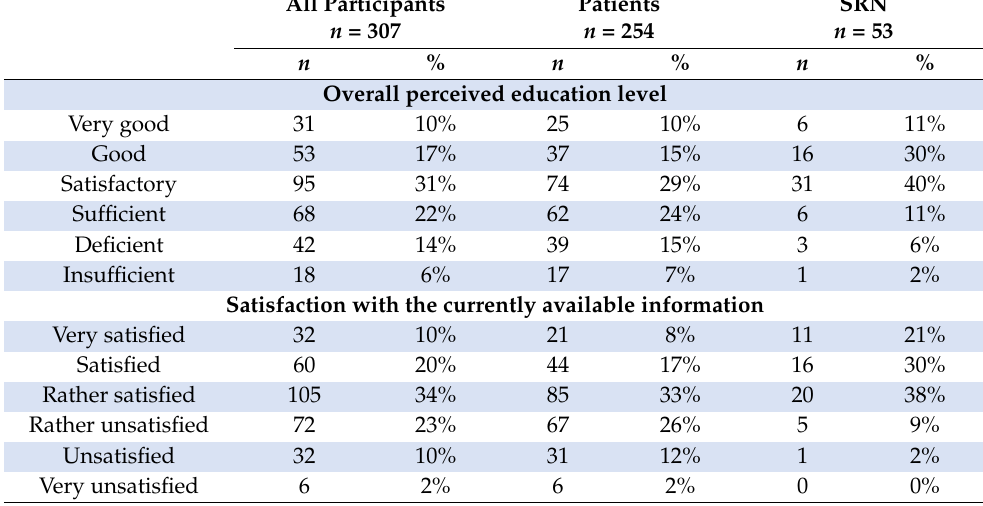
Table 3. Results—patients’ compared to SRN-perceived education levels and satisfaction with the currently available information